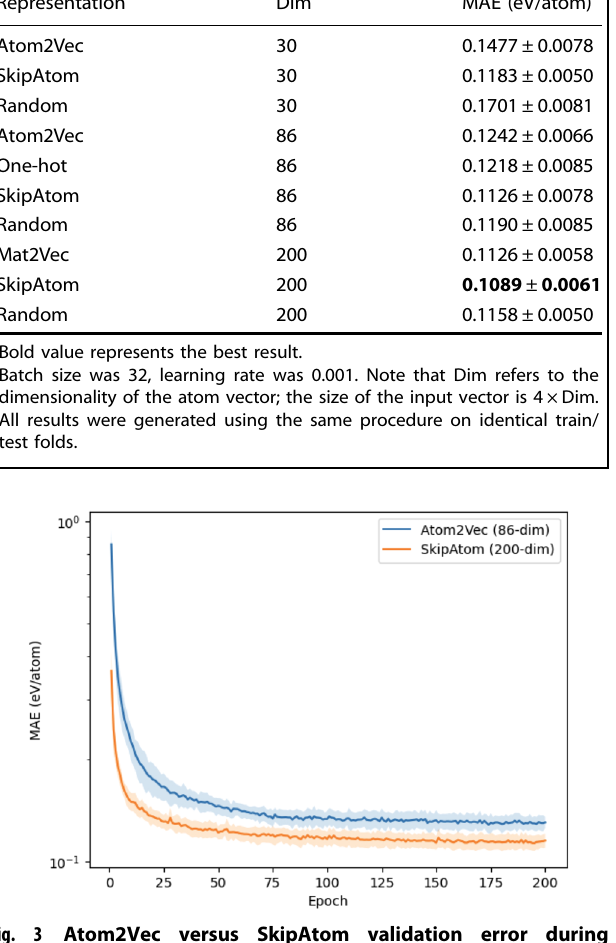
Table 2. Elpasolite formation energy prediction results after ten-fold cross-validation; mean best formation energy MAE on the test set after 200 epochs of training in each fold. Representation